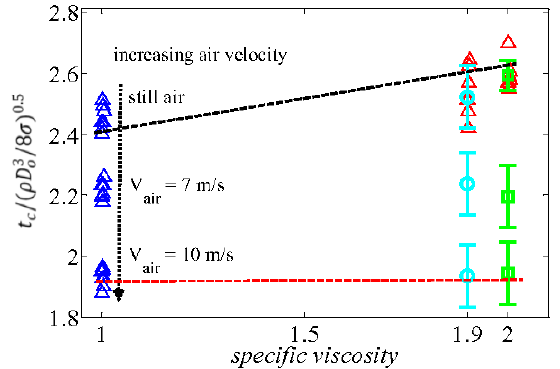
Figure 5. Comparison of dimensionless contact time of supercooled water droplet at various air speeds from 0 (i.e., still air) to 10 m/s. Results are also compared with water-glycerol (i.e., red triangle) solution with same viscosity to that of supercooled water drop (i.e., sky blue and green error bars represent supercooled water at − 2 ◦ C and − 3.5 ◦ C, respectively).